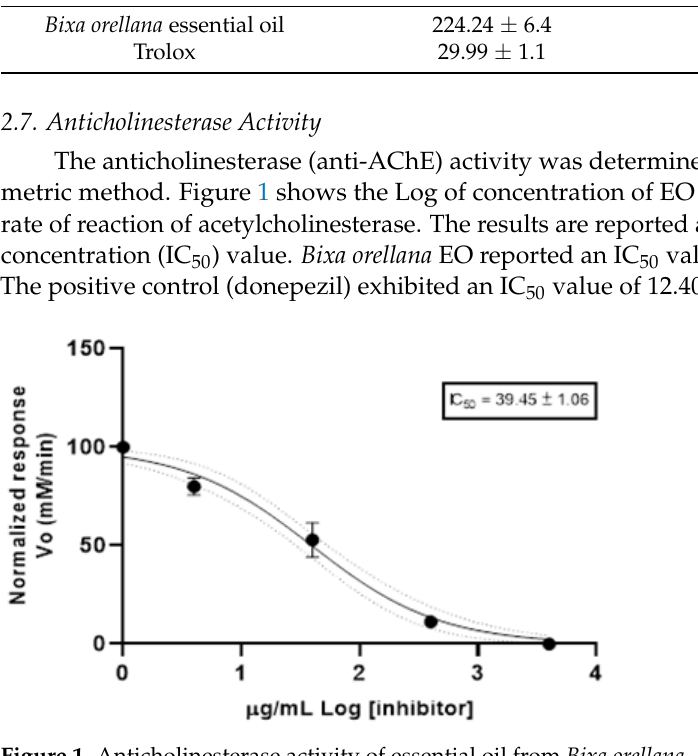
Figure 1. Anticholinesterase activity of essential oil from Bixa orellana .